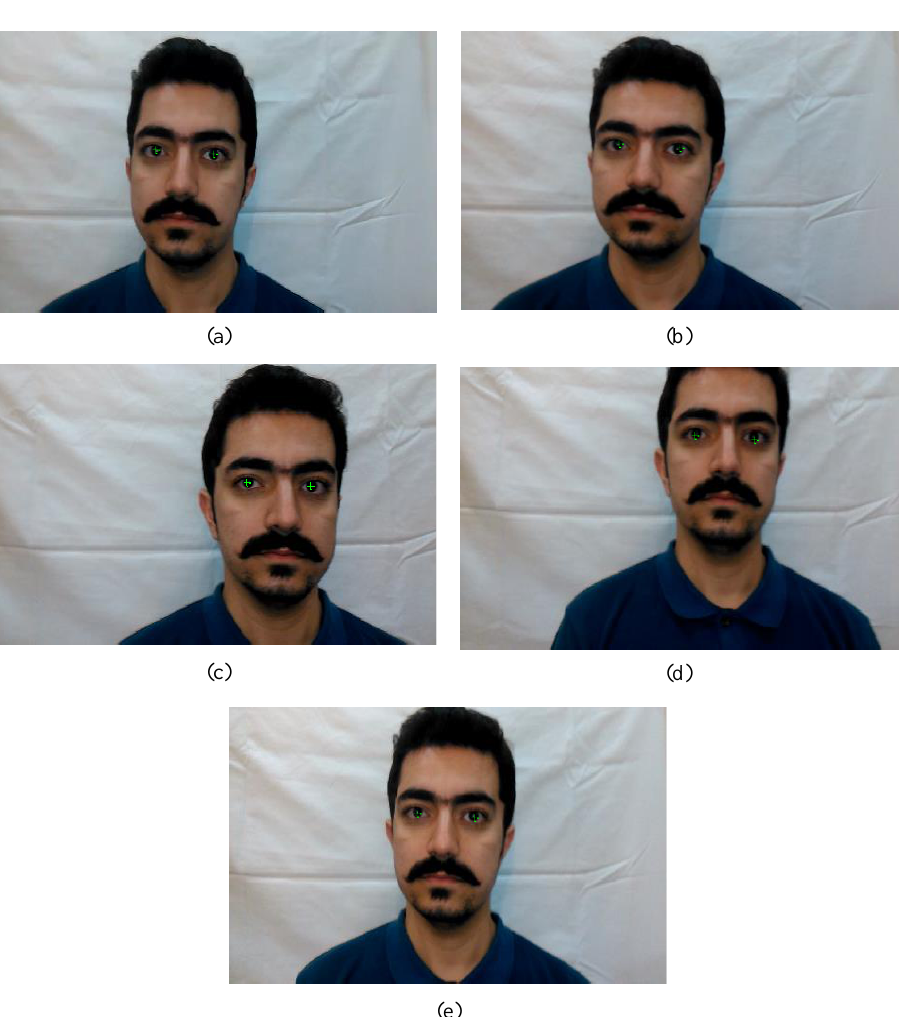
Figure 12. The results of eye tracking in the first scenario: a) frame 1; b) frame 50; c) frame 100; d) frame 150; c) frame 200 Figures 13 and 14 show how off the trace has been compared to real state of the eye.